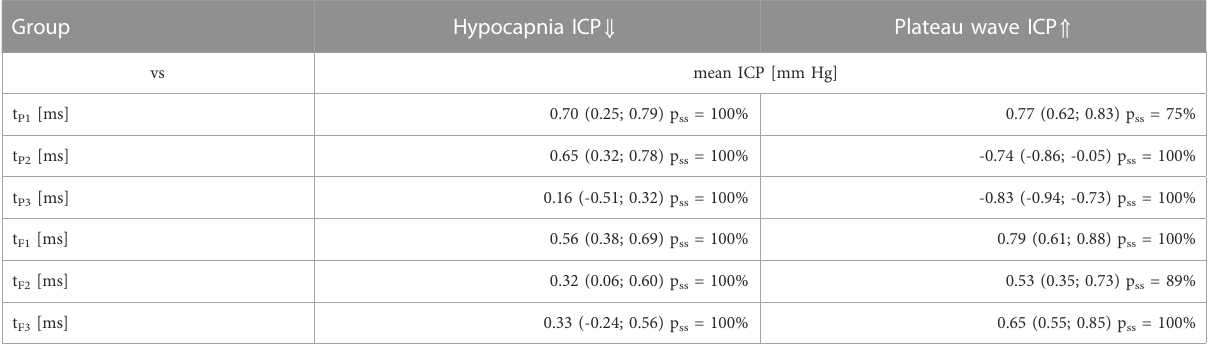
TABLE 2 Correlation analysis of individual ICP recordings (the whole monitoring period – from the beginning of baseline to the end of hypocapnia/plateau wave). Median Spearman ’ s correlation coef fi cient (r S ) values between mean intracranial pressure (ICP) and mean peak appearance times calculated from all statistically signi fi cant individual correlations with each